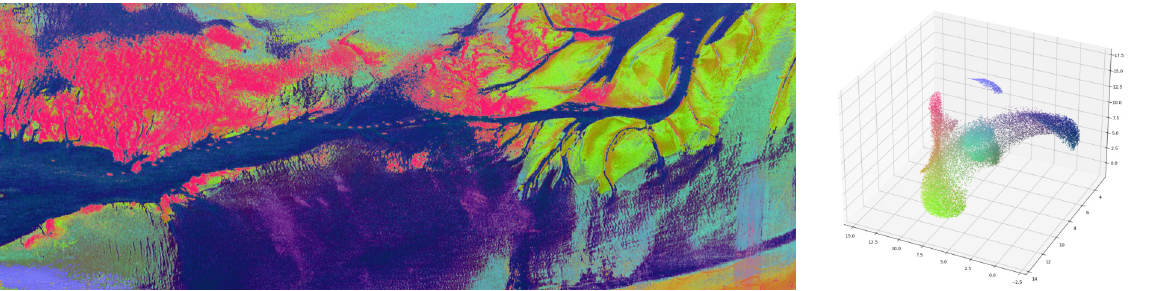
Figure 6. In (a) orthophotos of the onshore and offshore scene are given. (b) presents pseudo color images, which encode the 3D feature representation of the PolInSAR data. In (c) embedded data points are shown in 3D euclidean space.